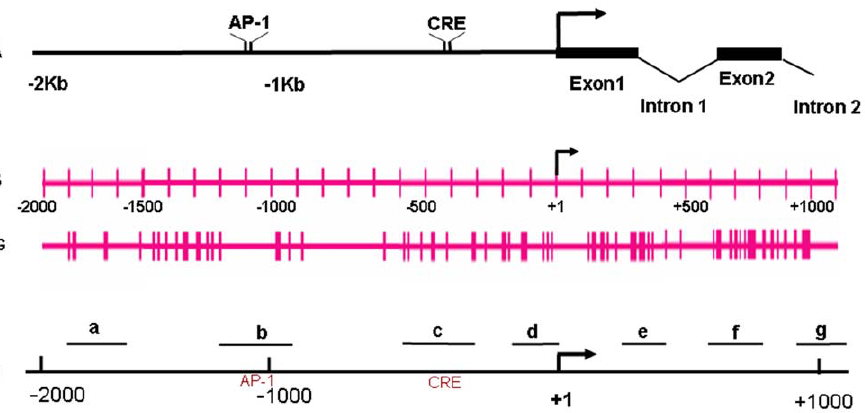
Figure 1. Schematic view of the 5 9 -regulatory area of the NR2B gene. A . The structure of 5 9 -regulatory area includes promoter (from 2 2000 bp to 0) and 5 9 -UTR region (from + 1 to + 1100 bp) of mouse NR2B gene, containing previously identified transcription factor CREB [38] and AP-1 [37] binding sites as indicated. B . The detailed distribution of CpG dinucleotides and their relative positions to AP-1 and CRE in 5 9 -regulatory area of the NR2B promoter is shown (note that the bars represent one or multi-CpG sites depending on the thickness). C . a to g represent the seven regions chosen in this study being amplified by qChIP PCR using different primer pairs in NR2B regulatory area and relative position in 5 9 -regulatory area of the NR2B (for the sequences of these primers see Table S1).